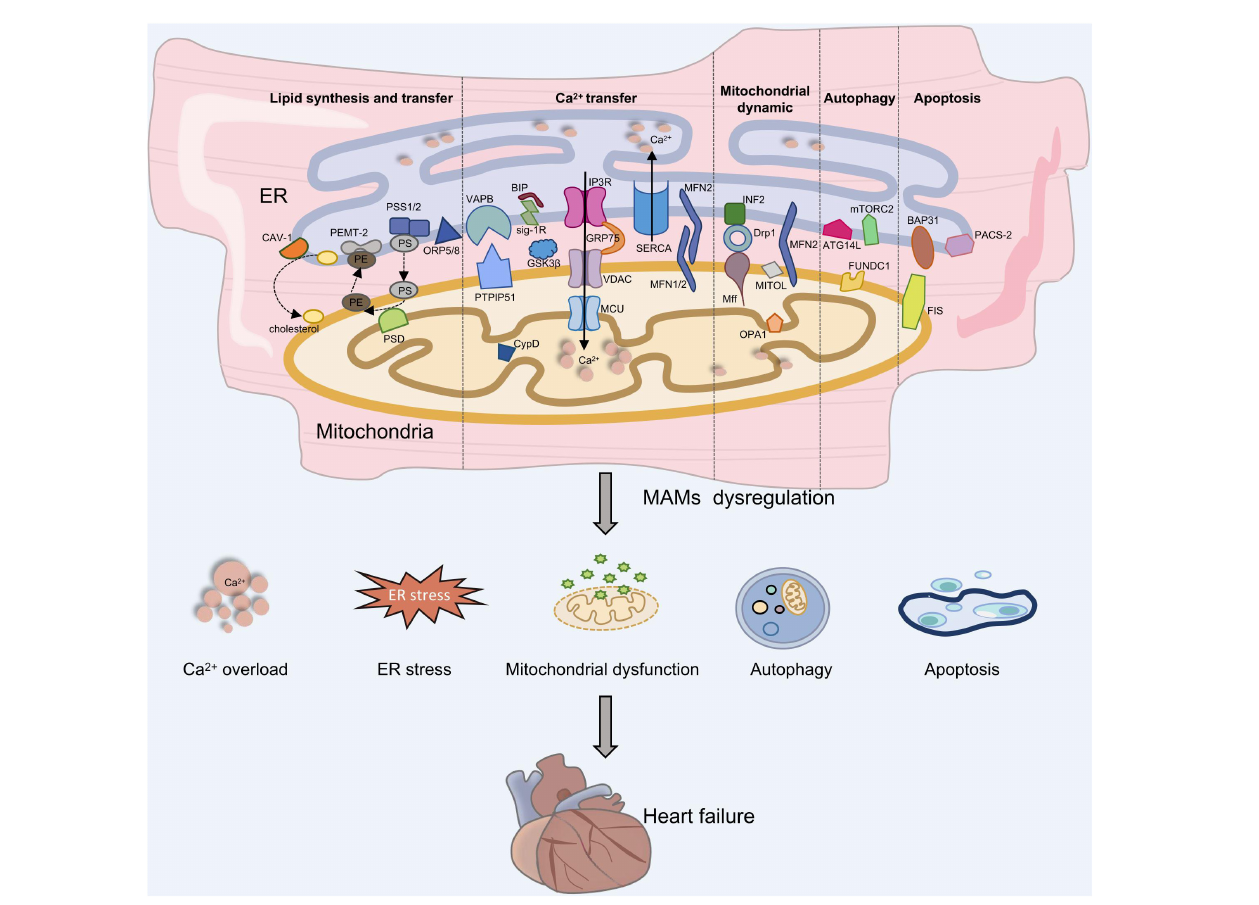
FIGURE1 The role of MAMs in heart failure development. Proteins located on the ER surface, such as IP3R, VAPB, MFN2, and BAP31 interact with their counterparts on the OMM like VDAC, PTPIP51 or ORP5/8, MFN1/2, and Fis1, forming four major tethering complexes at MAMs in mammalian cells. Depletion of MAMs can lead to Ca 2 + overload, ES stress, mitochondrial dysfunction, autophagy and apoptosis, which is involved in the development of heart